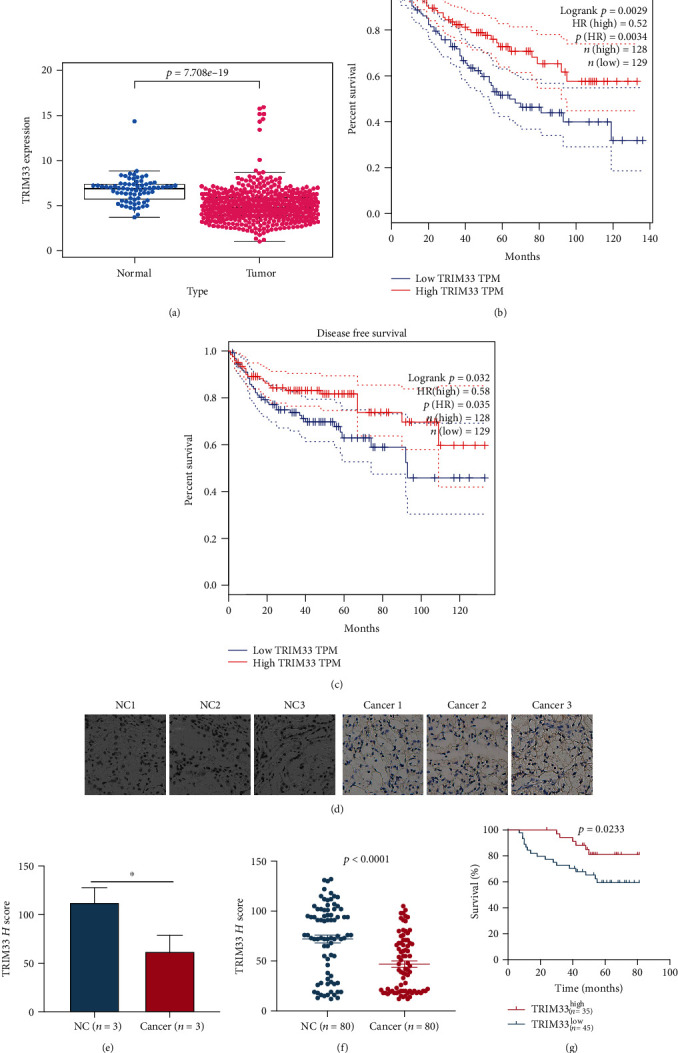
The expression of TRIM33 in kidney cancer tissues and normal tissues, and its relationship with the prognosis. (a) The expression of TRIM33 in kidney cancer tissues and normal tissues through the ccRCC data of the TCGA database; blue represents normal tissue and red represents tumor tissue, P = 7.708e‐19. (b and c) The relationship between OS, DFS, and TRIM33 expression in renal cell carcinoma patients. The cutoff value is 75%. (d and e) Immunohistochemical pictures of three typical kidney cancer tissues and normal tissues, and their H score. ∗P < 0.05. (f) Analysis of immunohistochemistry results of 80 cases of kidney cancer tissues and normal tissues. P < 0.0001. (g) The survival curve is drawn according to TRIM33 expression. P = 0.0233.